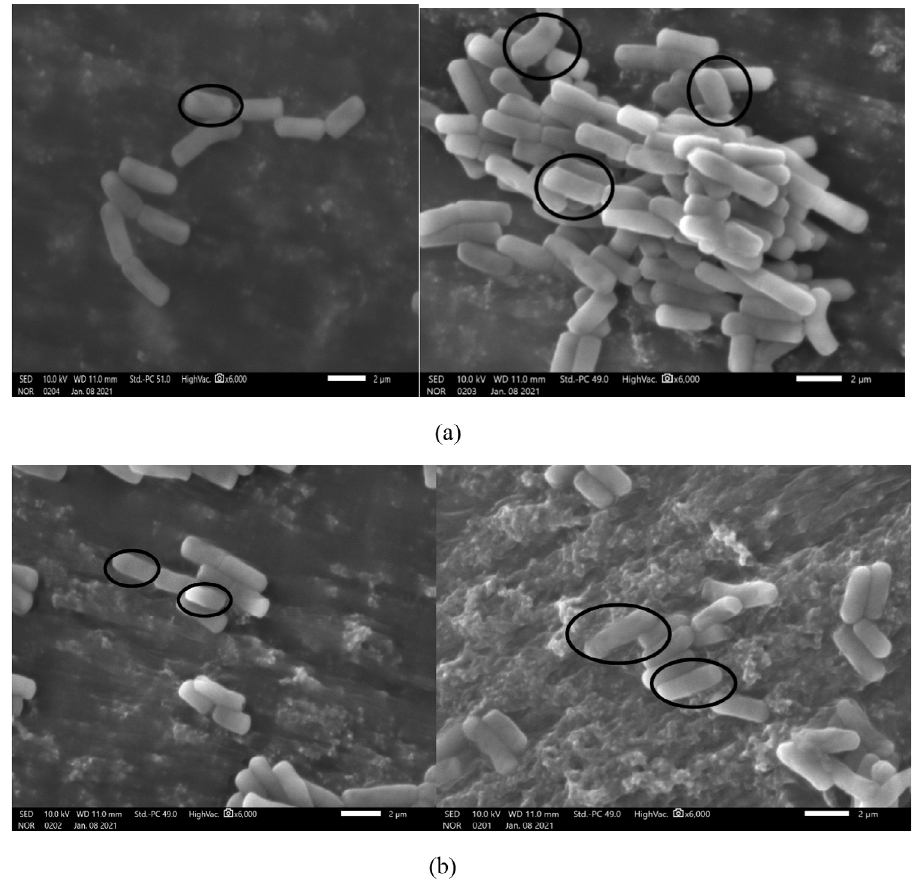
Fig. 2. Scanning electron microscopic images of a) ECd004 (b) SCd005 (Absence and presence of